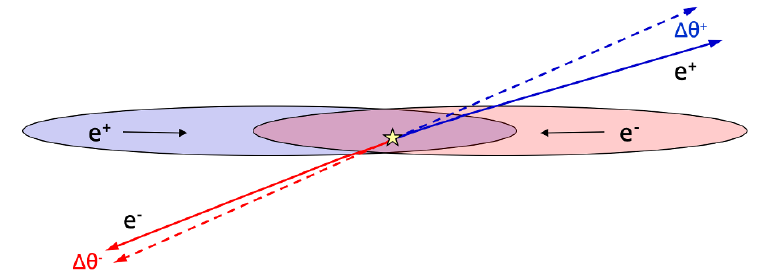
Figure 1 . Illustration of the focusing electromagnetic force that is experienced by the charged leptons emerging from a Bhabha interaction, in the case of head-on collisions. The dashed lines show the original direction of the leptons, while the full lines show their direction after the electromagnetic de(cid:13)ection induced by the opposite charge bunch. The case of collisions with a nonzero crossing angle is illustrated in section